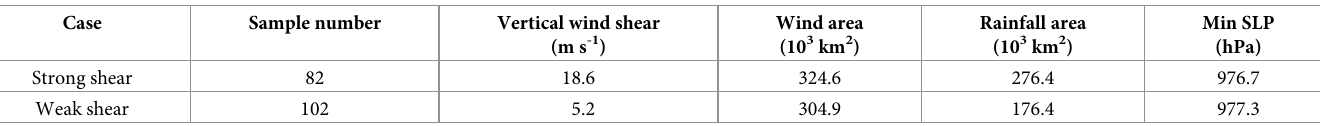
Table 2. The average vertical wind shear, wind area, rainfall area, and minimum sea level pressure of TCs for the strong and weak shear cases. Statistically significant differences between the two cases for vertical wind shear and rainfall area appear at the 95% confidence level evaluated with Student’s t